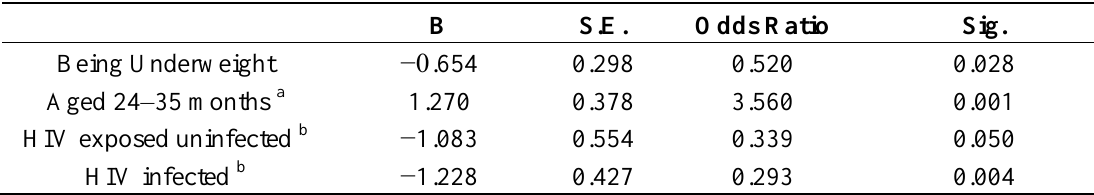
Table 3. Results of a logistic regression analysis on the predictors of inability to complete the A-not-B